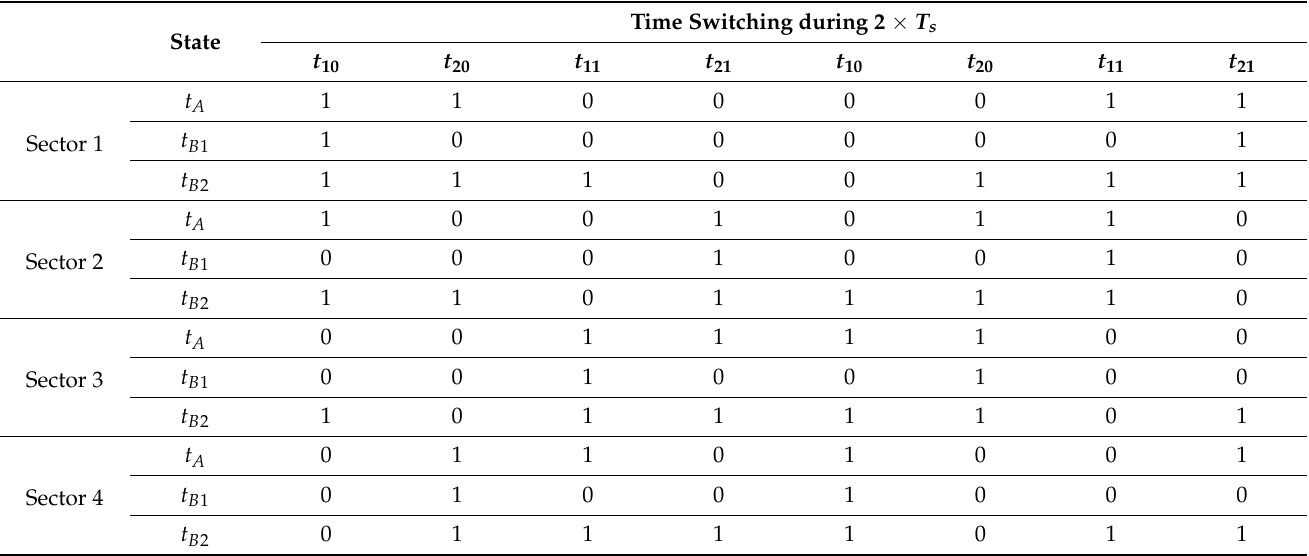
Table 2. Switching arrangement for the advanced SVM symmetrical modulation